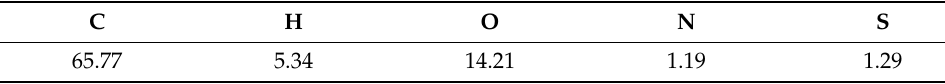
Table 3. Coal ultimate analysis (in wt%).